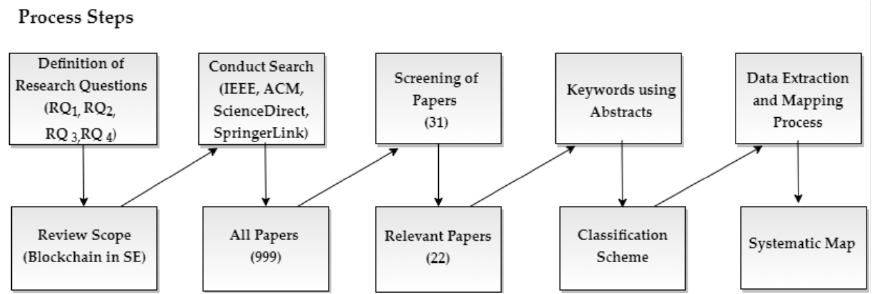
Figure 2. Overview of the systematic mapping study, adapted from